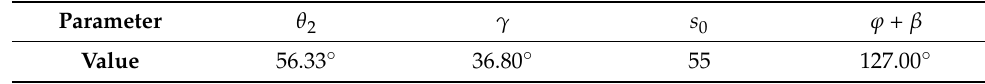
Table 5. Variables at the instant of oral jaw biting.